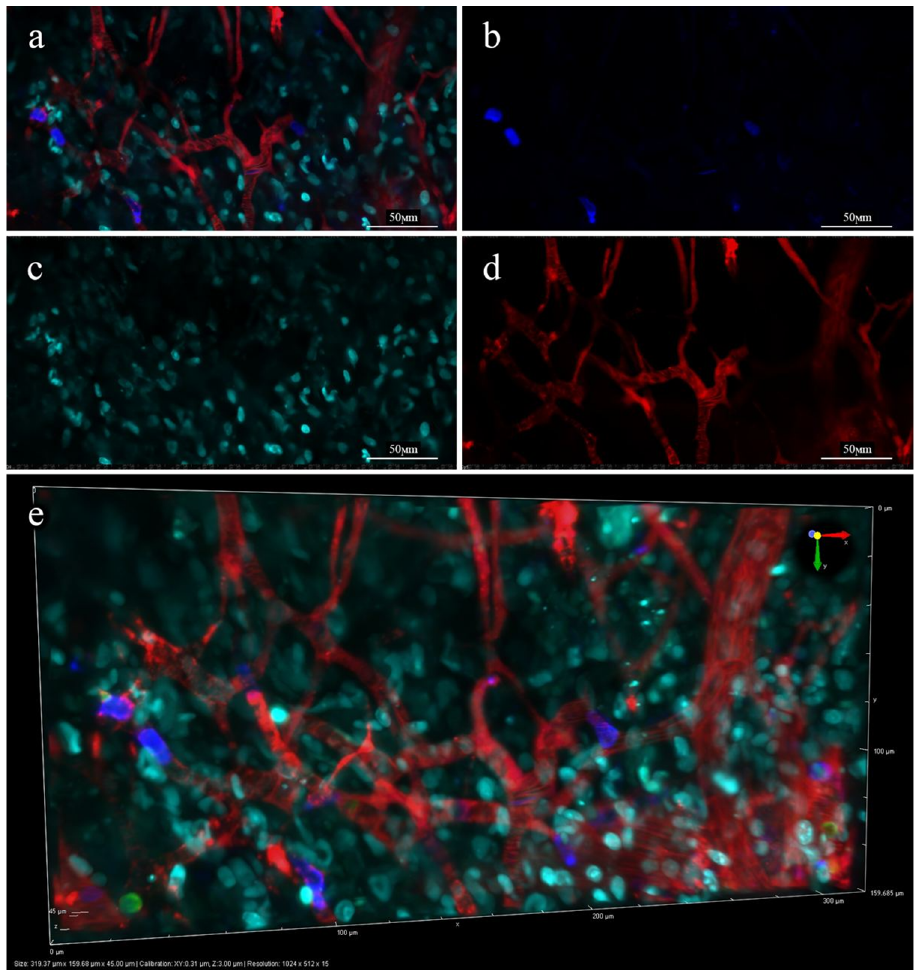
Figure 11. Investigation of Dox-PLGA-Cy5 microdistribution in 4T1 subcutaneous tumor. Representative IVM images. ( a ) Merged image; ( b ) Ly6G-positive neutrophils; ( c ) Dox; ( d ) PLGA-Cy5 NP; ( e ) 3D reconstruction of peritumoral tissue fragment. Scale bar—50 µm.